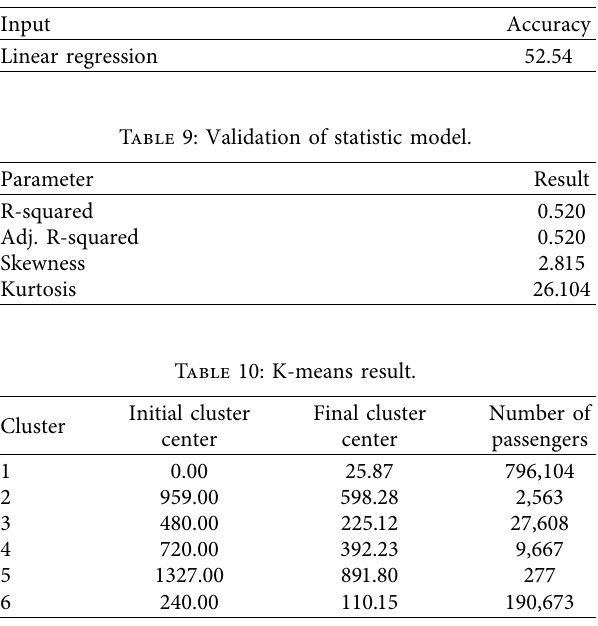
Table 8: Accuracy of linear regression.